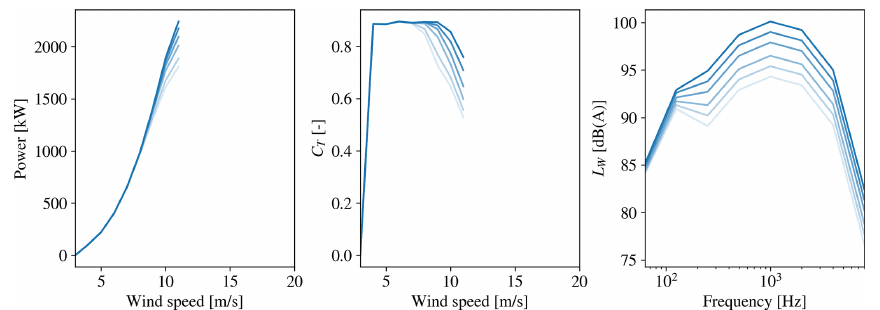
Figure 2. SWT-2.3-93: the power, C T and L W curves for each operational mode at U hub = 10ms − 1 . From dark to light blue is the least noise reducing mode, m = 0, to the most noise reducing mode, m = 6. Data are only available for wind speeds up to 11ms − 1 for this wind turbine.